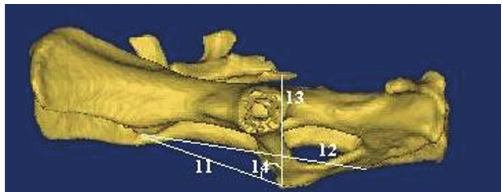
Figure 5: Measurements on facies lateralis sinistra of pelvic